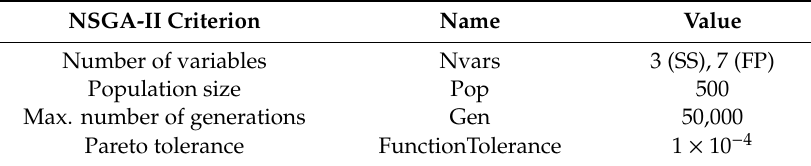
NSGA-II: nondominated sorting genetic algorithm.